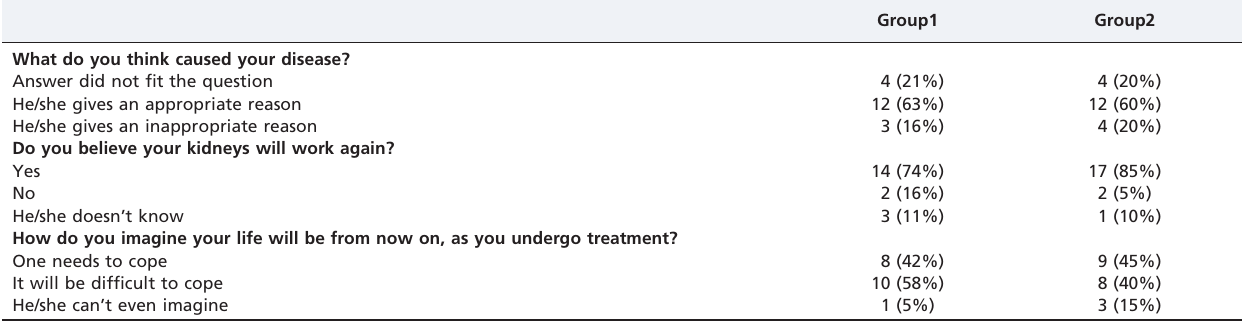
Table 5 - Beliefs, feelings and